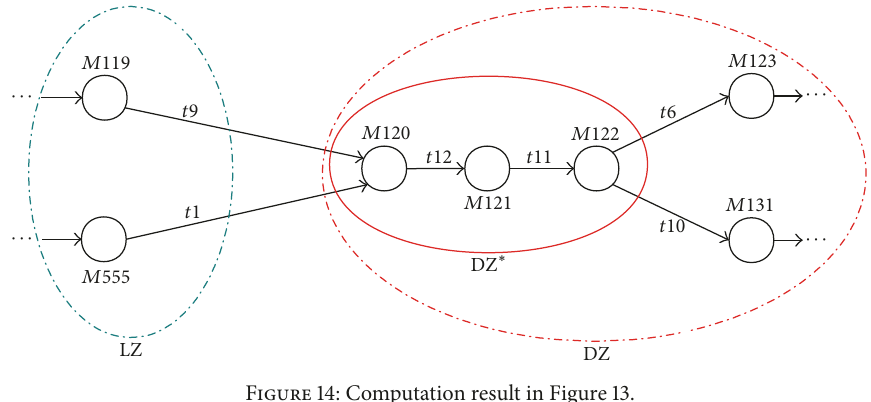
Figure 14: Computation result in Figure 13.